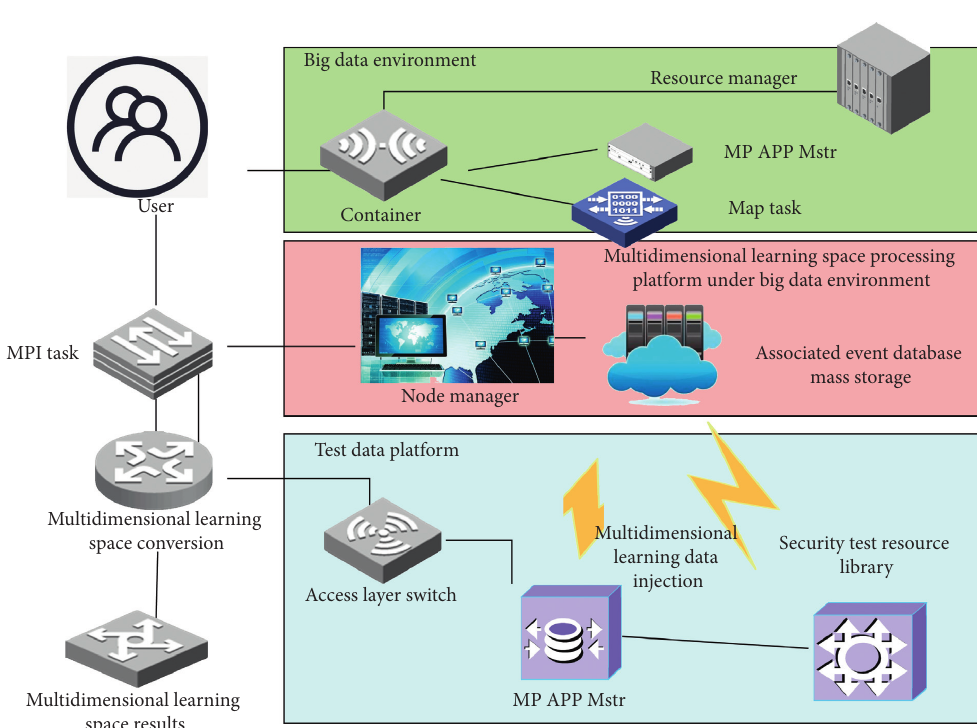
Figure 4: YARN’s resource management